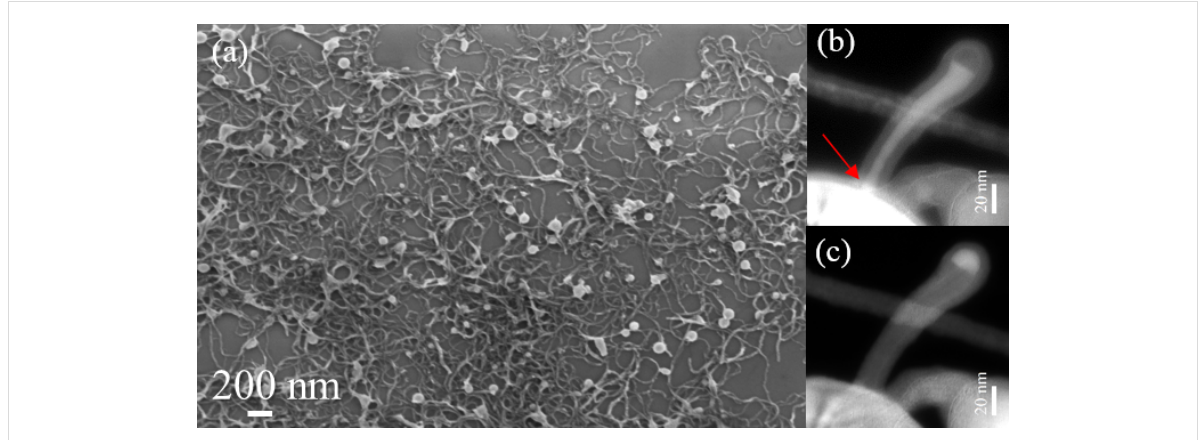
Figure 1: (a) Typical SEM image showing the morphology of the as-collected sample; EFTEM images obtained at (b) the Si plasmon loss (17 eV) and (c) the SiO 2 plasmon loss (23 eV), revealing the Si–SiO 2 core–shell structure and the structural continuity between the Si core of the SiNW and the SiNS, as indicated by the red arrow in (b).